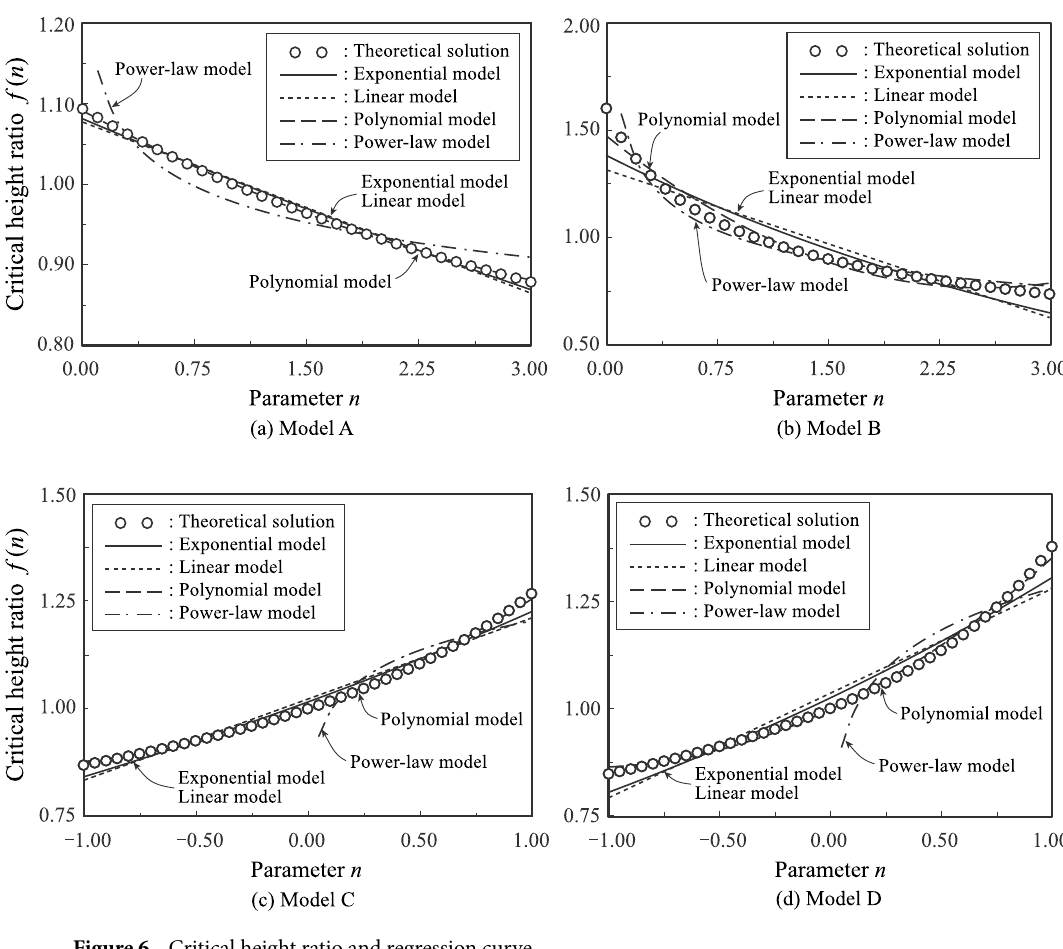
Figure 6. Critical height ratio and regression curve.